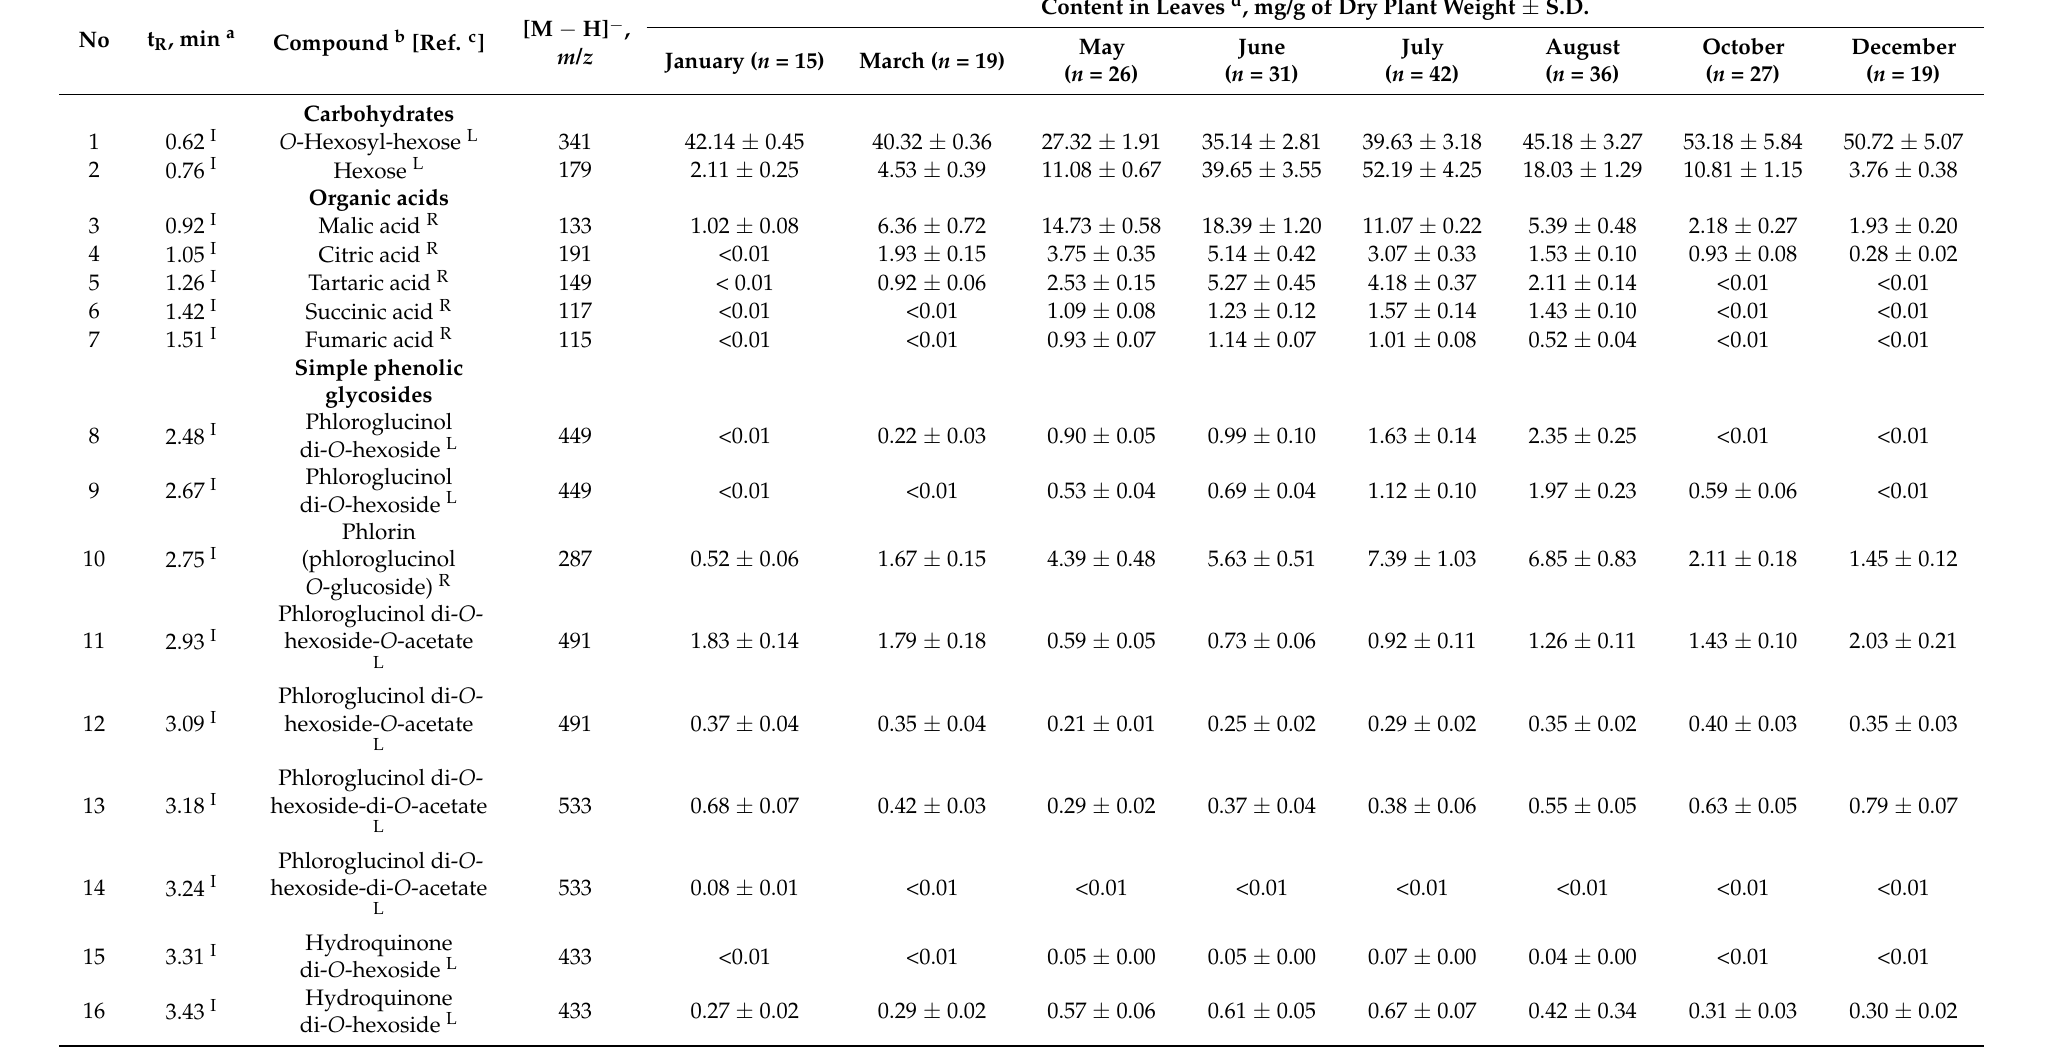
Table 3. Compounds 1 – 171 were found in R. adamsii leaves with their seasonal